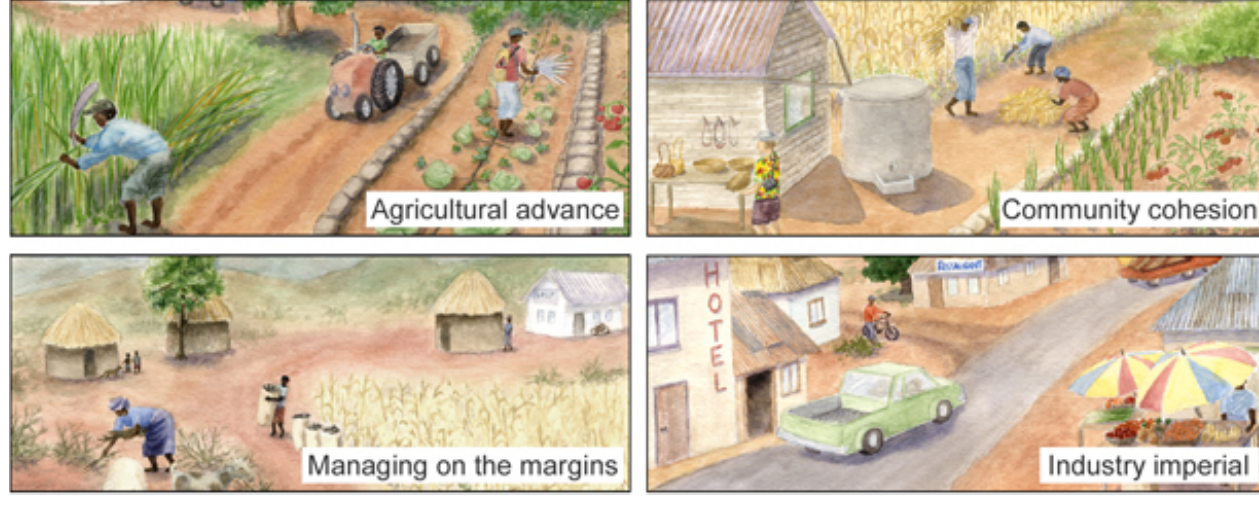
Fig. 3. Four scenarios for Makanya’s future. The figure gives an impressionistic illustration of how the conditions in Makanya vary in the four scenarios. Central to the figure is one of Makanya’s crossroads, which is a strong symbol of change. “Agricultural advance” describes a future dominated by a rapid market-oriented agricultural development. In “Managing on the margins,” the dry climate makes farming-based livelihoods difficult and people have to struggle to provide for their families. “Community cohesion” centers on collective action and small-scale improvements of current farming systems. “Industry imperial” describes a future where smallholder farming loses importance as people start working in industries and factories, and where the traditional lifestyle increasingly becomes abandoned. Illustration: C.